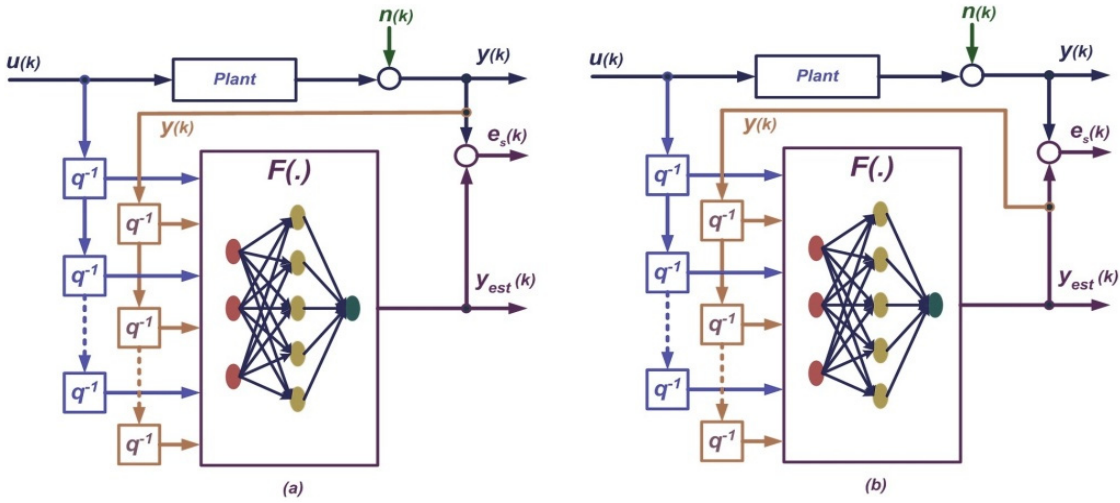
Figure 7. NARX Structures: ( a ) series-paralleland ( b ) parallel.